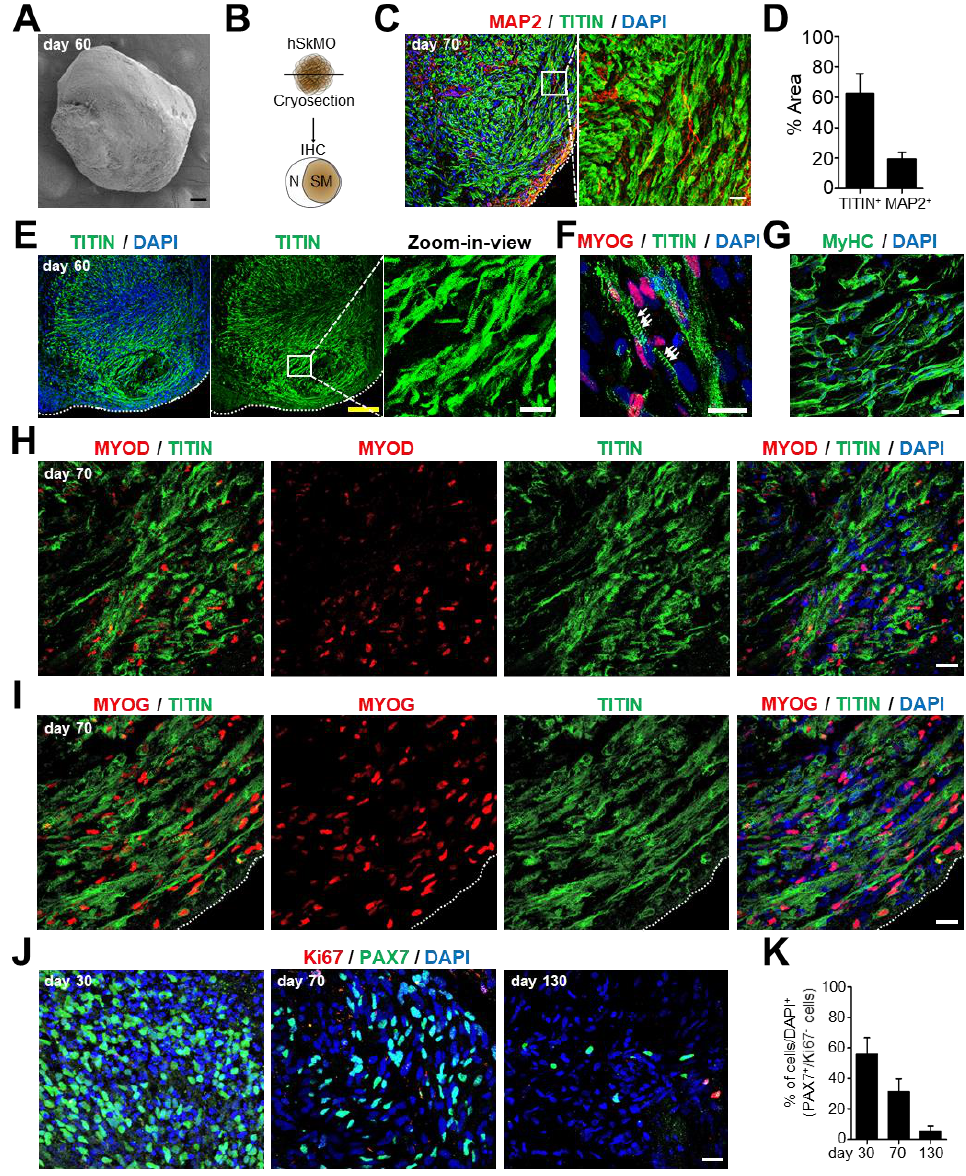
Figure 3. Characterization of mature hSkMOs. ( A ) SEM image of day 60 hSkMO. Scale bar, 100 µ m. ( B ) Schematic representation of cryosection and the predicted proportion of skeletal muscle (SM)